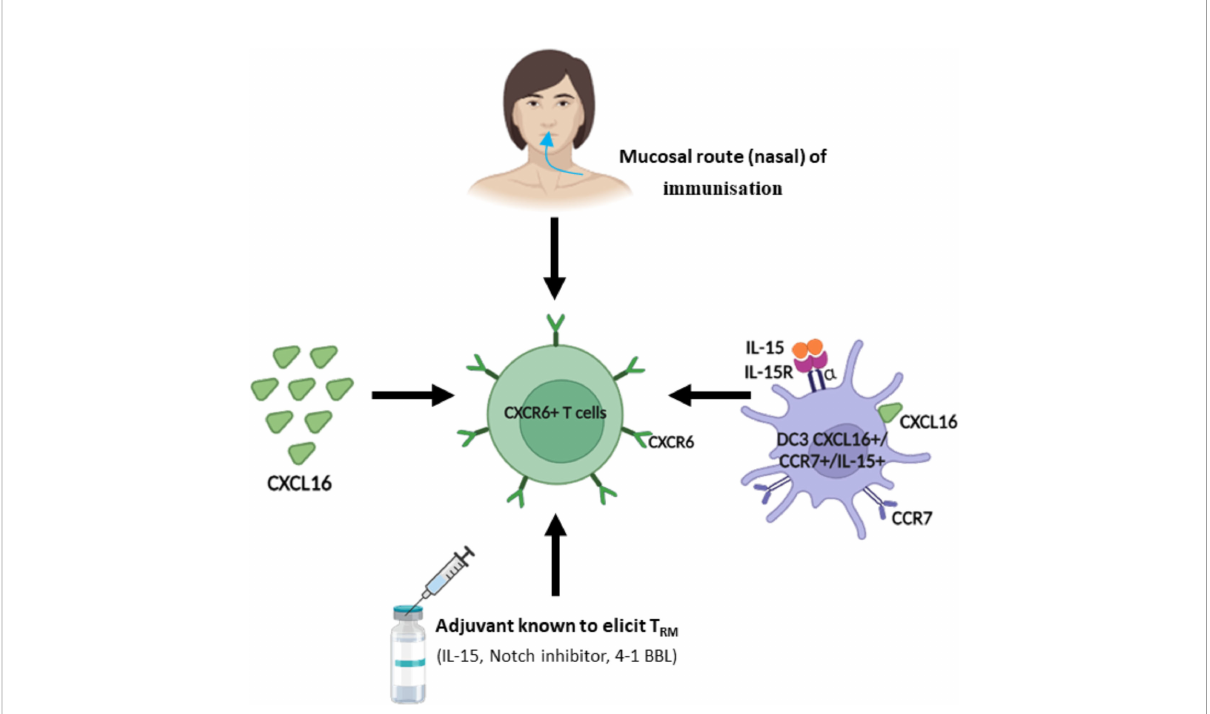
FIGURE 2 Strategy to regulate and induce CXCR6 + T cells.In light of the role of CXCR6 + T cells in tumor control, different strategies have been proposed to induce or increase their recruitment in the tumor microenvironment. As the majority of CXCR6 + T cells are included in the resident memory T cell population (T RM ), many strategies are common with those aimed at inducing T RM